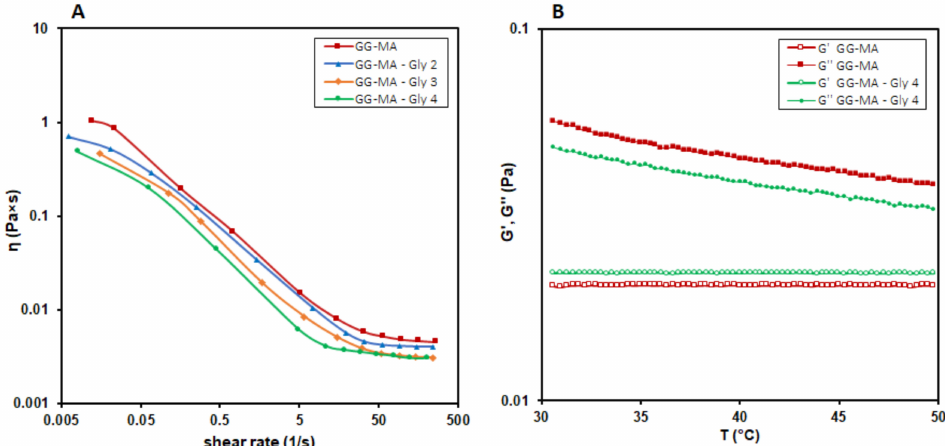
Figure 2. Effect of Gly on ( A ) the flow properties and ( B ) the sol-gel transition of GG-MA solutions (2% w/v